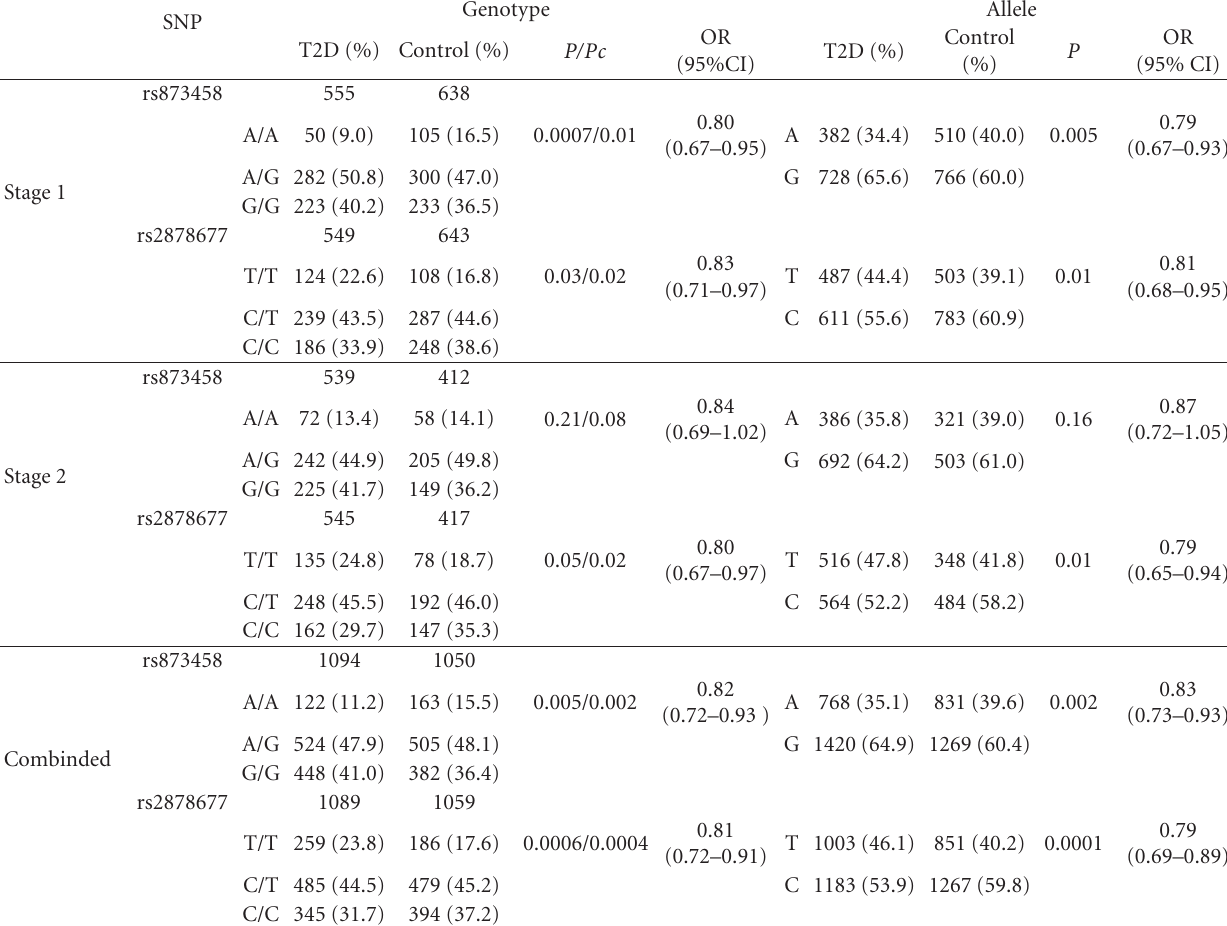
Table 3: Allele frequencies and genotype distributions of rs873458 and rs2878677 in MFN2 gene among stage 1 and stage 2 populations.